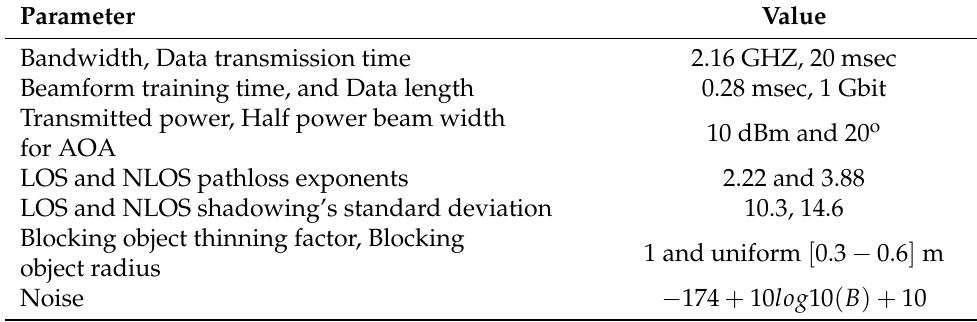
Figure 4. Utilized mmWave D2D system model. Table 3. Case study simulation